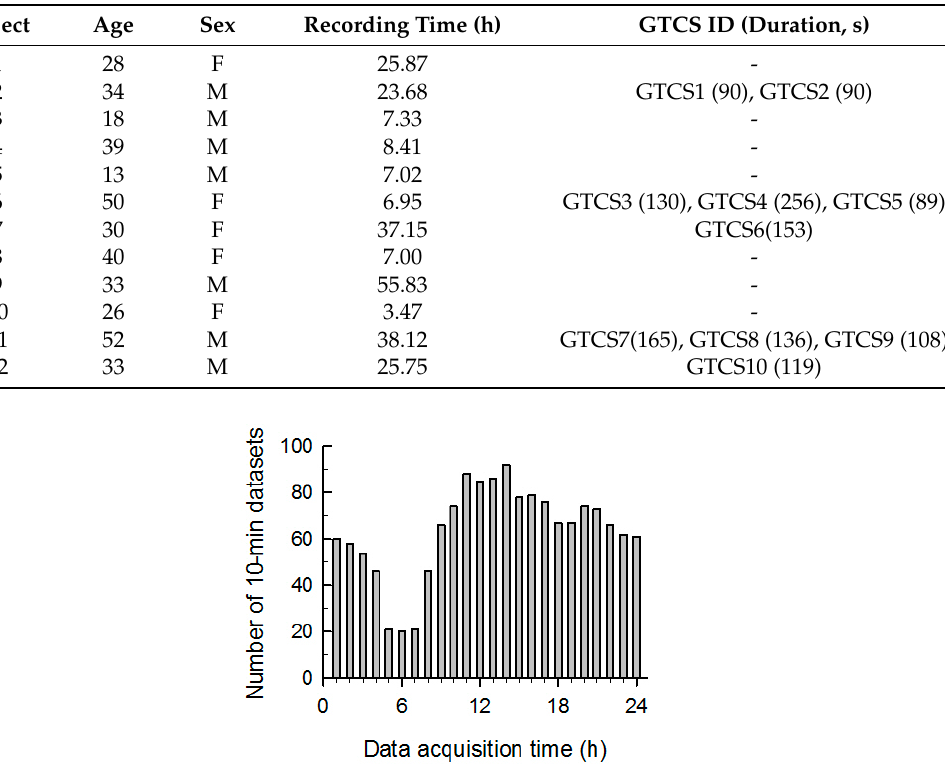
Table 1. Subject, recording duration, and seizure data.